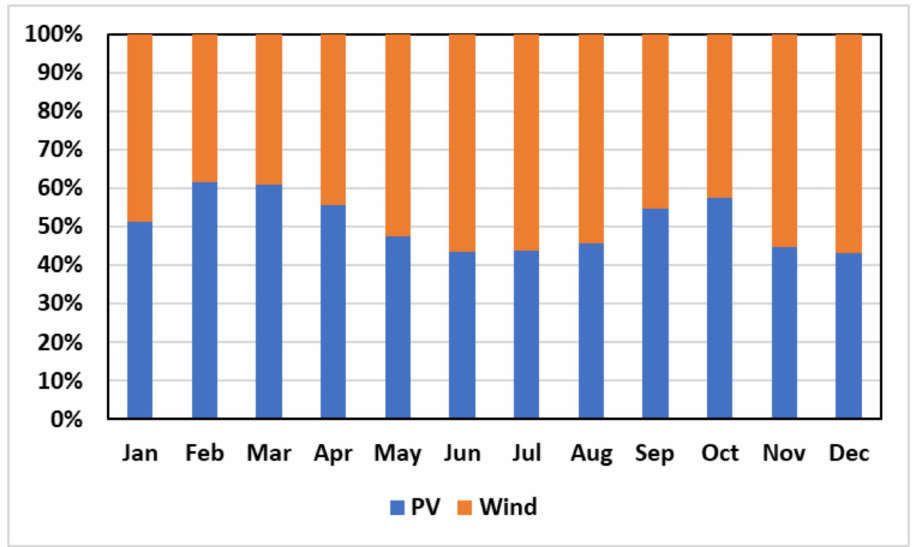
Figure 7. Monthly energy contribution of